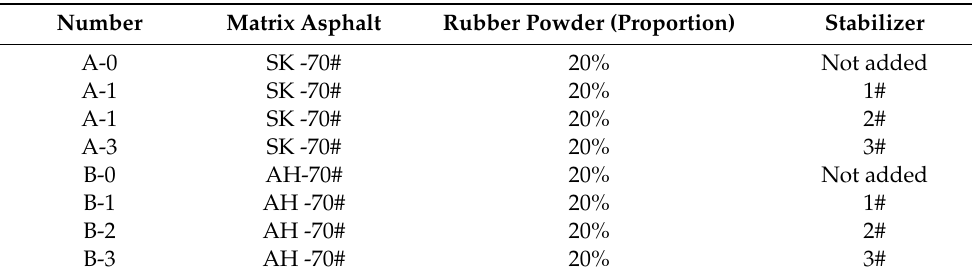
Table 5. Asphalts rubber sample preparation